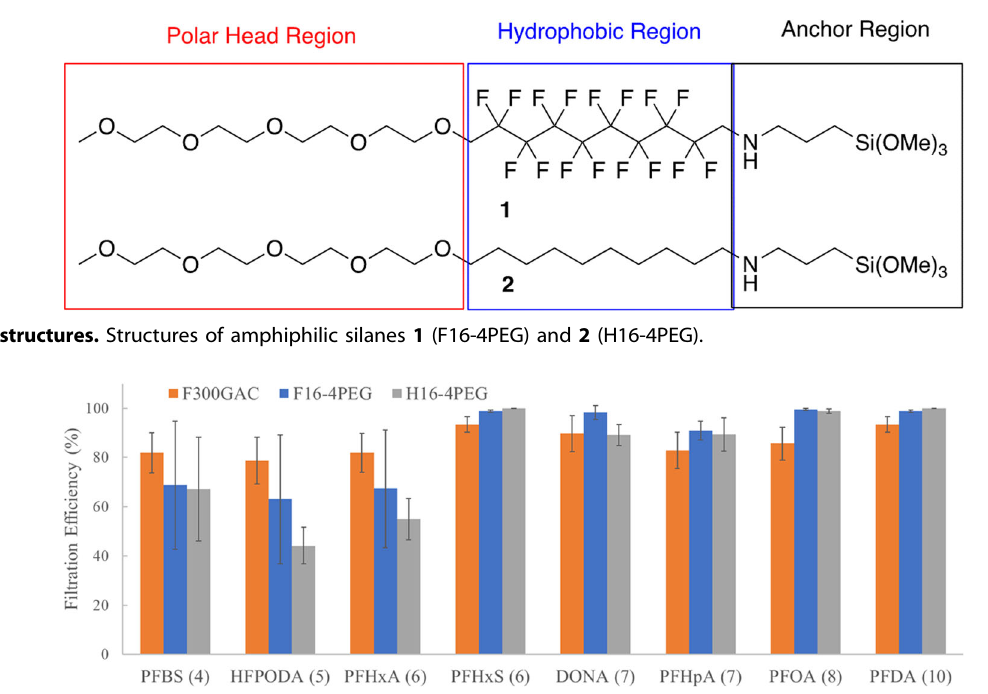
Fig. 2 Dynamic fi ltration experiment results. Percent removal of eight of the eighteen PFAS compounds under dynamic fi ltration of 100 ppt samples for the F300GAC, as well as F16-4PEG and H16-4PEG functionalized 4603 fi lters. The number of linear carbon atoms in each species is noted in parenthesis. For complete results see the Supplementary Table 1. Error bars represent the standard deviation for two independent